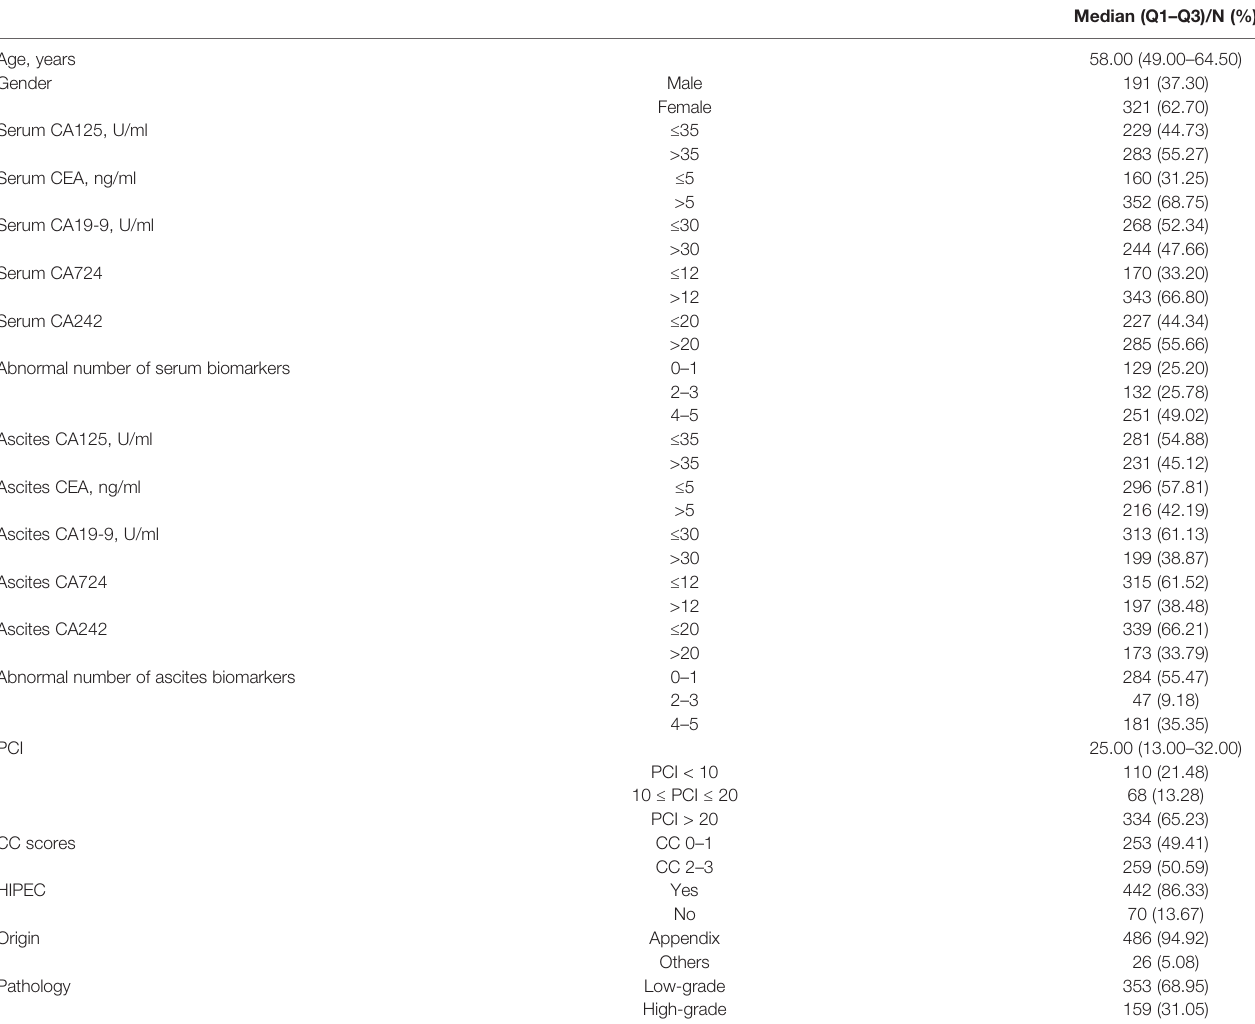
TABLE 1 | The demographic characteristics of the enrolled PMP